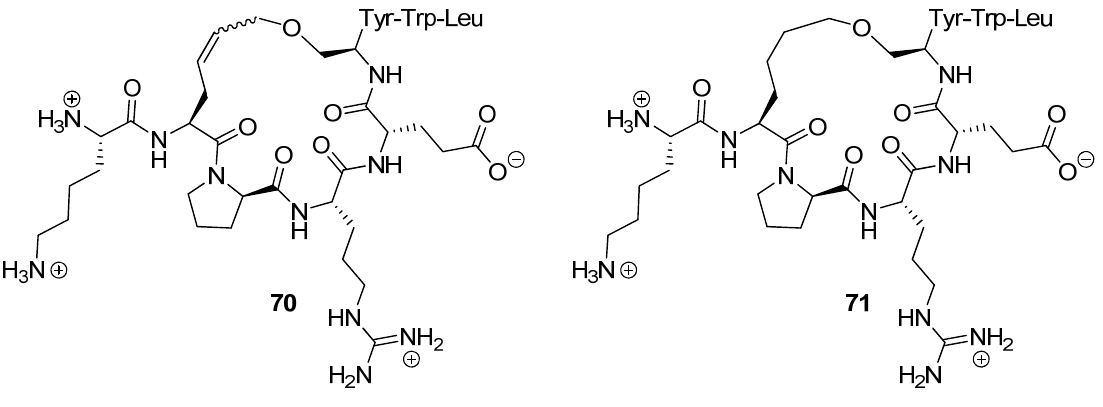
Figure 17. Artificial human high affinity IgE receptor α -chain (ecFc ε RI α ) receptors for binding of the antibody